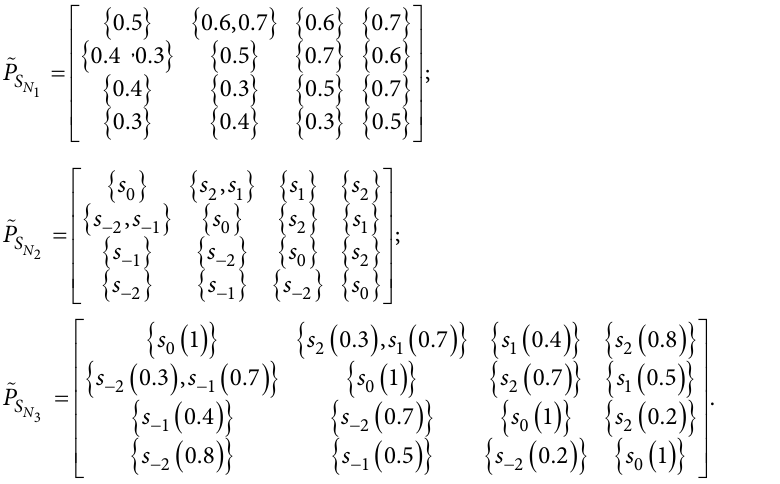
Table 5. Rankings based on four preference relations (source: our research) Preference relations Alternative rankings The NPLPR > > > 1 2 3 x The